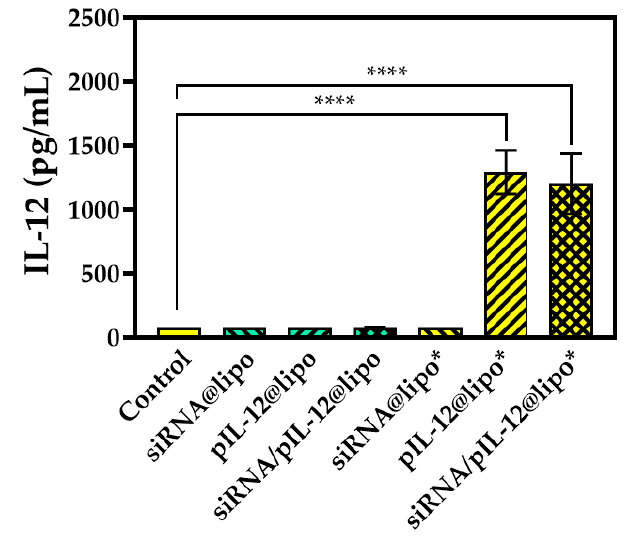
Figure 7. IL-12 expression in J774A.1 cells treated with different complexes for 48 h at the siRNA concentration of 300 pmol/mL and/or the pIL-12 concentration of 5 μ g/mL. J774A.1 cells without treatment were used as a control (**** p < 0.0001; n = 3).